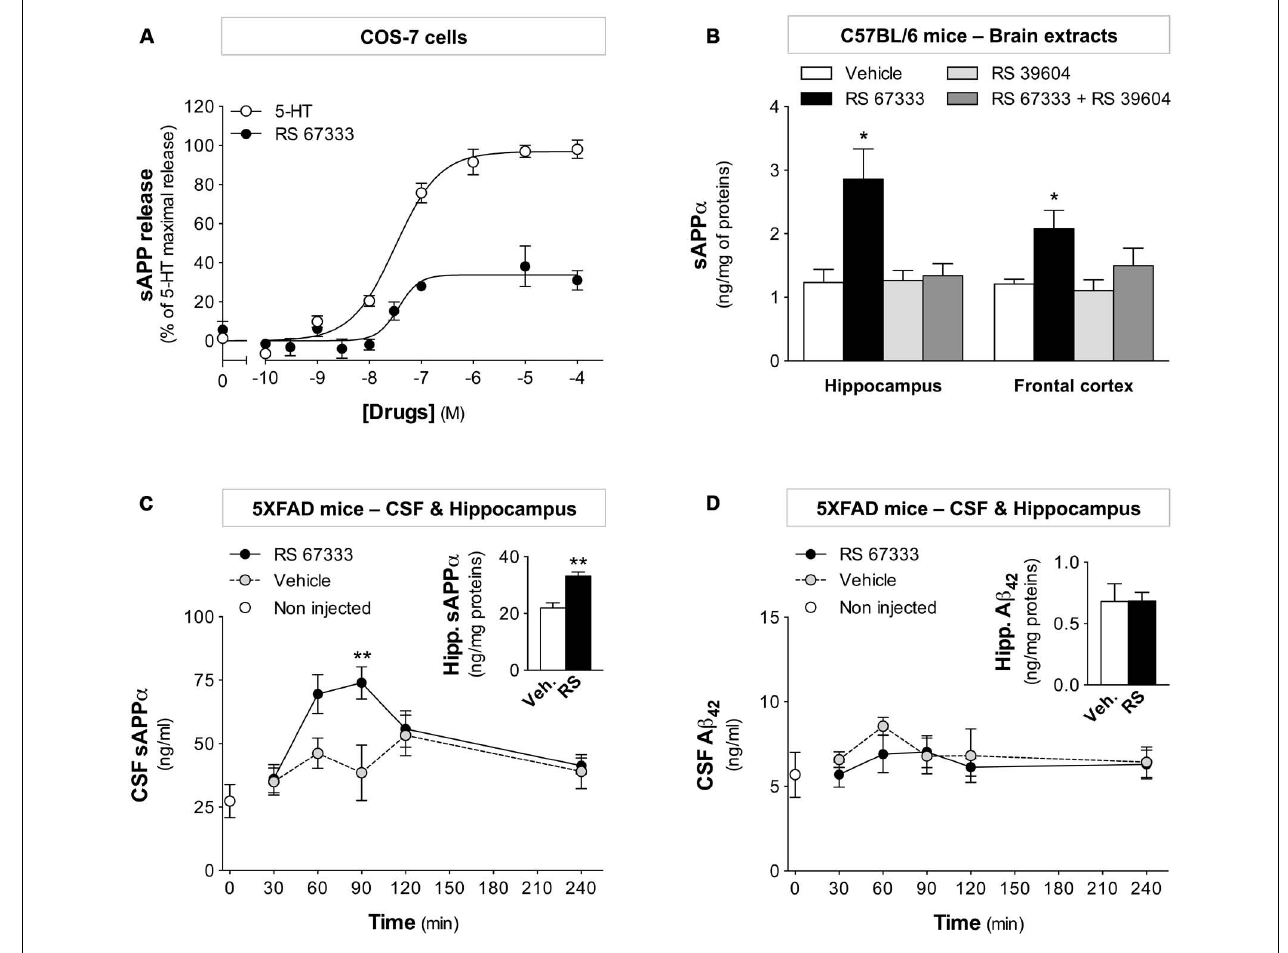
FIGURE 1 |The RS 67333 5-HT 4 receptor agonist induces sAPP α release in vitro and in vivo . (A) COS-7 cells that transiently express 5-HT 4 receptors and SEAP-APP were stimulated with increasing concentrations of serotonin or RS 67333 for 30 min and then sAPP release in culture supernatants was measured by quantification of alkaline phosphatase activity. Data are the mean ± SEM of values obtained in a typical experiment performed in triplicate.Two other experiments performed on different sets of cultured cells yielded similar results. (B) sAPP α levels in hippocampus and frontal cortex extracts of C57BL/6 mice were quantified 30 min after one i.p. injection of